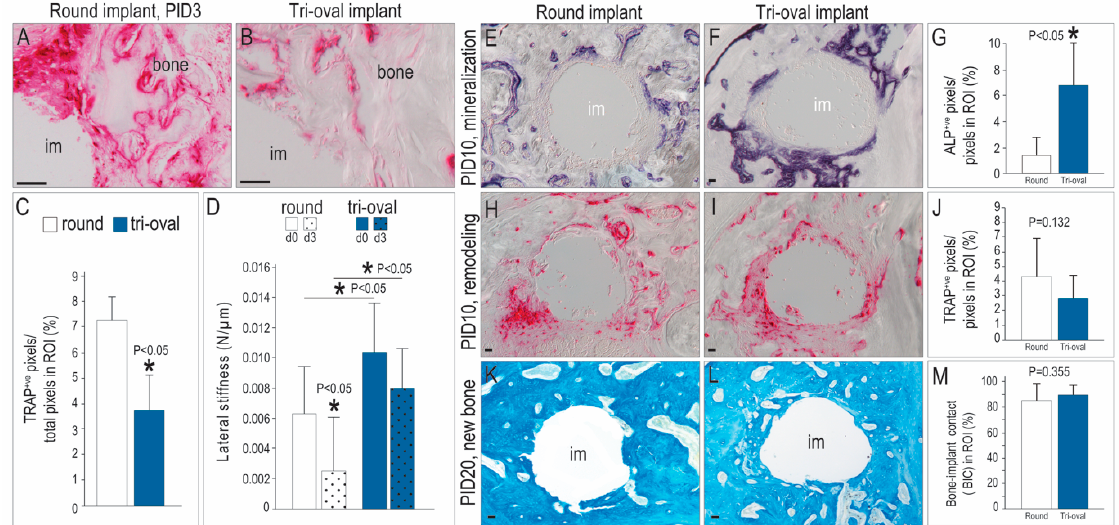
Figure 3. Tri-oval implants exhibits less bone resorption but more robust mineralization. ( A ) TRAP staining of interfacial tissues surrounding a representative round implant on PID3. ( B ) TRAP staining of the minima region around a tri-oval implant on PID3. ( C ) TRAP staining was quantified around the entire circumference of round and tri-oval implants. ( D ) Lateral stiffness test of round and tri-oval implants on PID0 and 3. ( E ) ALP staining of interfacial tissues surrounding a representative round and ( F ) a tri-oval implant on PID10, quantified in ( G ). ( H ) TRAP staining of interfacial tissues surrounding a representative round and ( I ) a tri-oval implant on PID10, quantified in ( J ). ( K ) Aniline blue staining of interfacial tissues surrounding a representative round and ( L ) a tri-oval implant on PID20; quantified in ( M ). Abbreviations as previously stated. Scale bars = 50 µm.